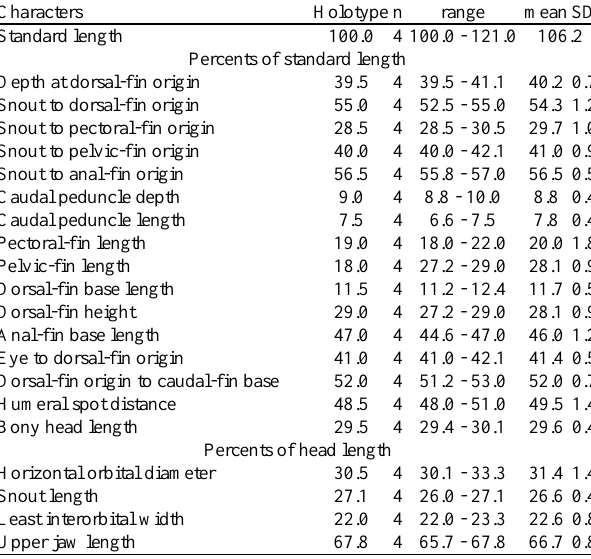
Table 4. Morphometrics of Charax delimai . Specimens are from MZUSP 81505 (holotype) and 84988